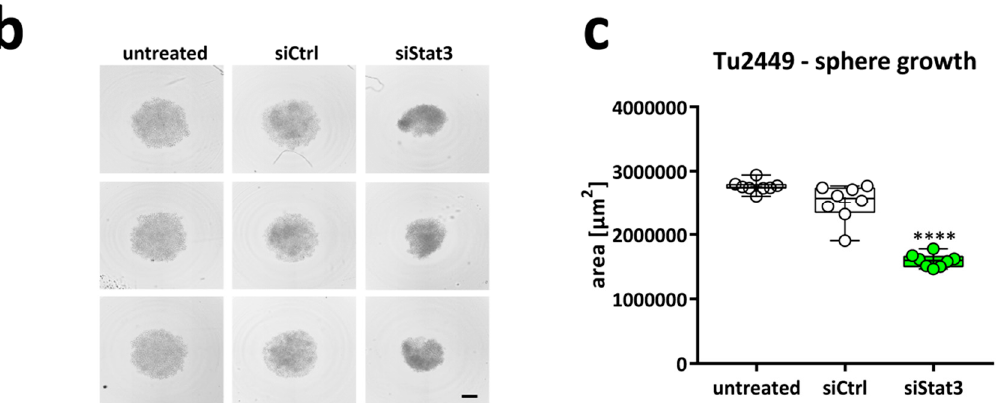
Figure 3. ( a ) Cell cycle analysis of Tu2449 cells after transfection of siCtrl or siStat3. A significant increase in the percentage of cells in the G1 phase suggests antiproliferative properties of Stat3-depletion. ( b , c ) Sphere growth assay of Tu2449 after transfection of siCtrl or siStat3. Three representative spheres for each condition are presented in ( b ) the quantification after 10 days of sphere growth is shown. Scale bar: 500 µ m. ( c ) as box-plots (min-to-max) with all samples displayed as circles; the horizontal line in the box depicts the median value, the plus-symbol the mean. *: p < 0.0.05; **: p < 0.01 and ****: p < 0.0001 compared to siCtrl treatment. A representative experiment of at least three independent repetitions is shown.